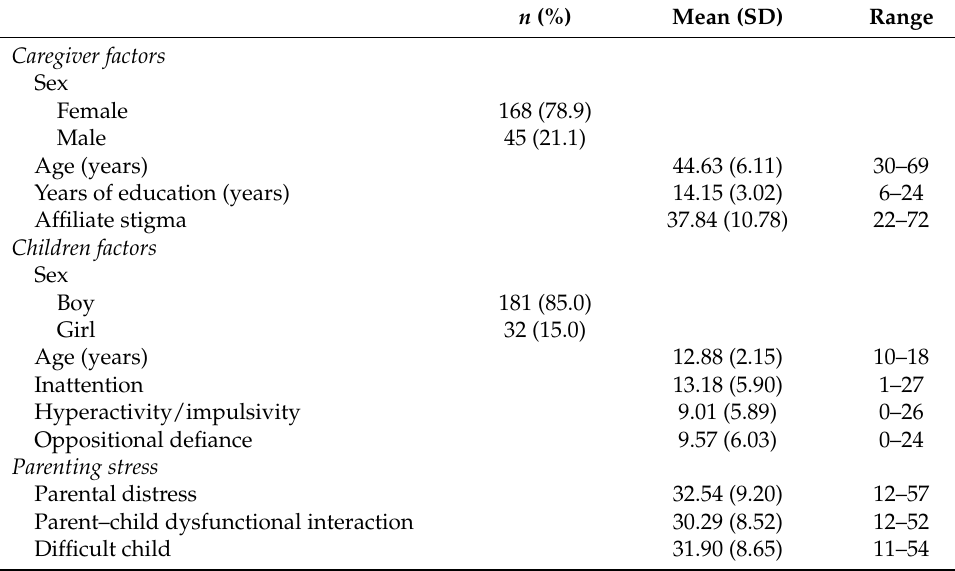
Table 1. Caregiver and Child Factors and Parenting Stress (N =